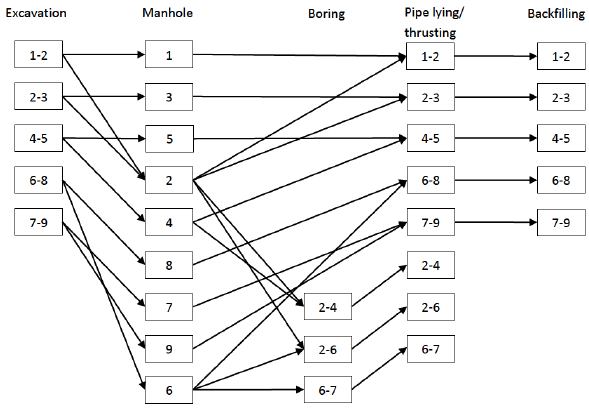
Figure 2: Activities relationships in piping